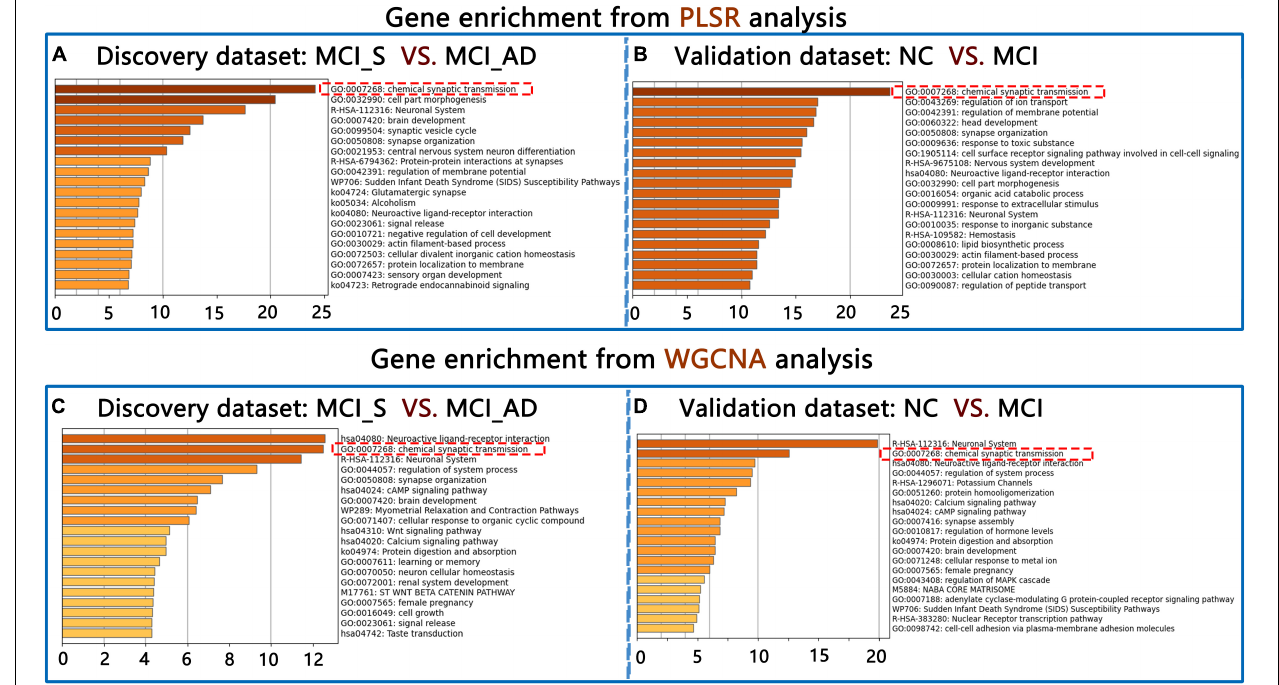
FIGURE 3 | Gene enrichment results from PLSR and WGCNA in the discovery dataset (A,C) and the validation dataset (B,D) .